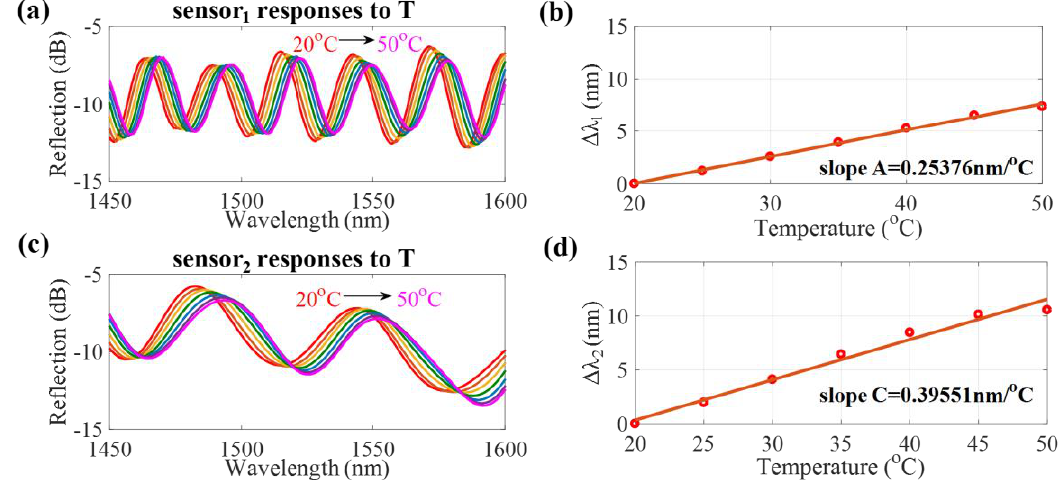
Figure 4. ( a , c ) Interference spectra of sensor 1 and sensor 2 for different T values, respectively; ( b , d ) Corresponding T sensitivities for sensor 1 and sensor 2 , respectively.